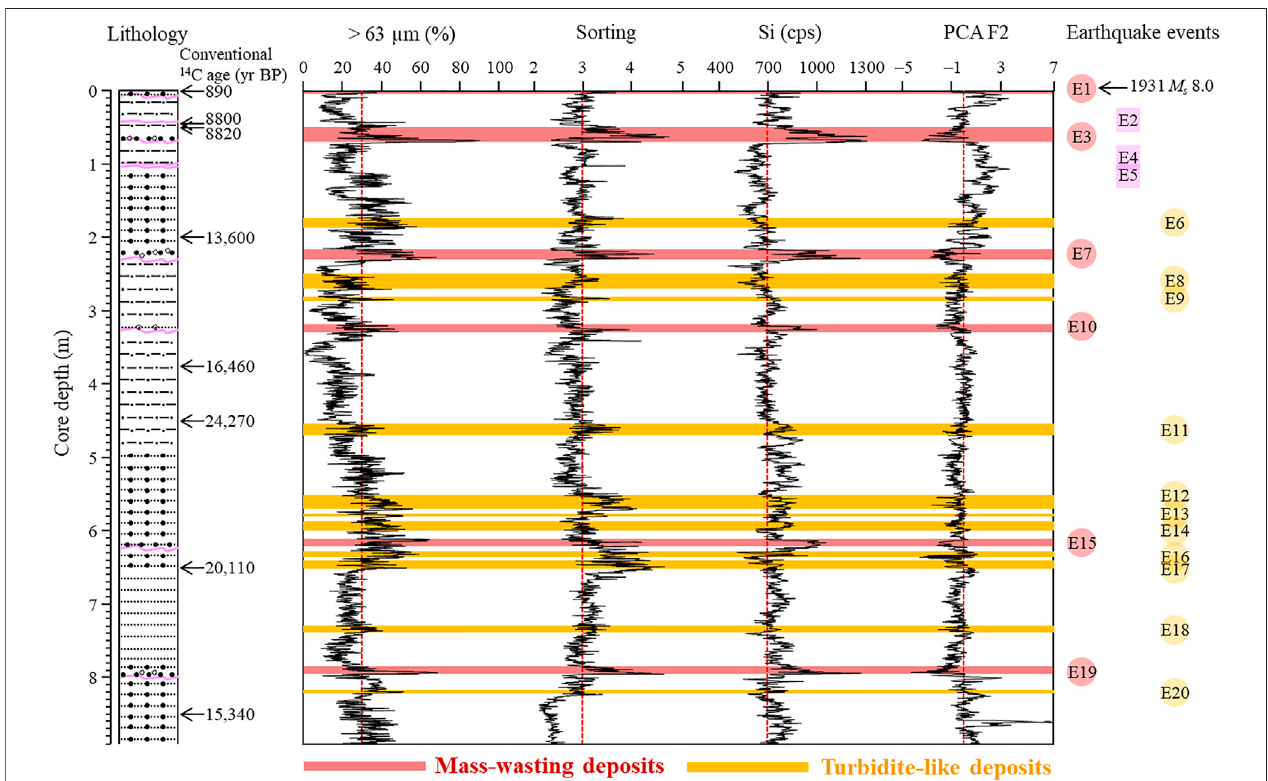
FIGURE7| Sedimentaryrecordofpastearthquakesinferredfromthemass-wastingdepositswithunderlyingSSDS(E1,E3,E7,E10,E15andE19),isolatedSSDS (E2, E4 and E5) and turbidite-like seismites (E6, E8 – E9, E11 – E14, E16 – E18 and E20) from the Y20B core. Lithological legends and conventional 14 C ages are same as Figure 2